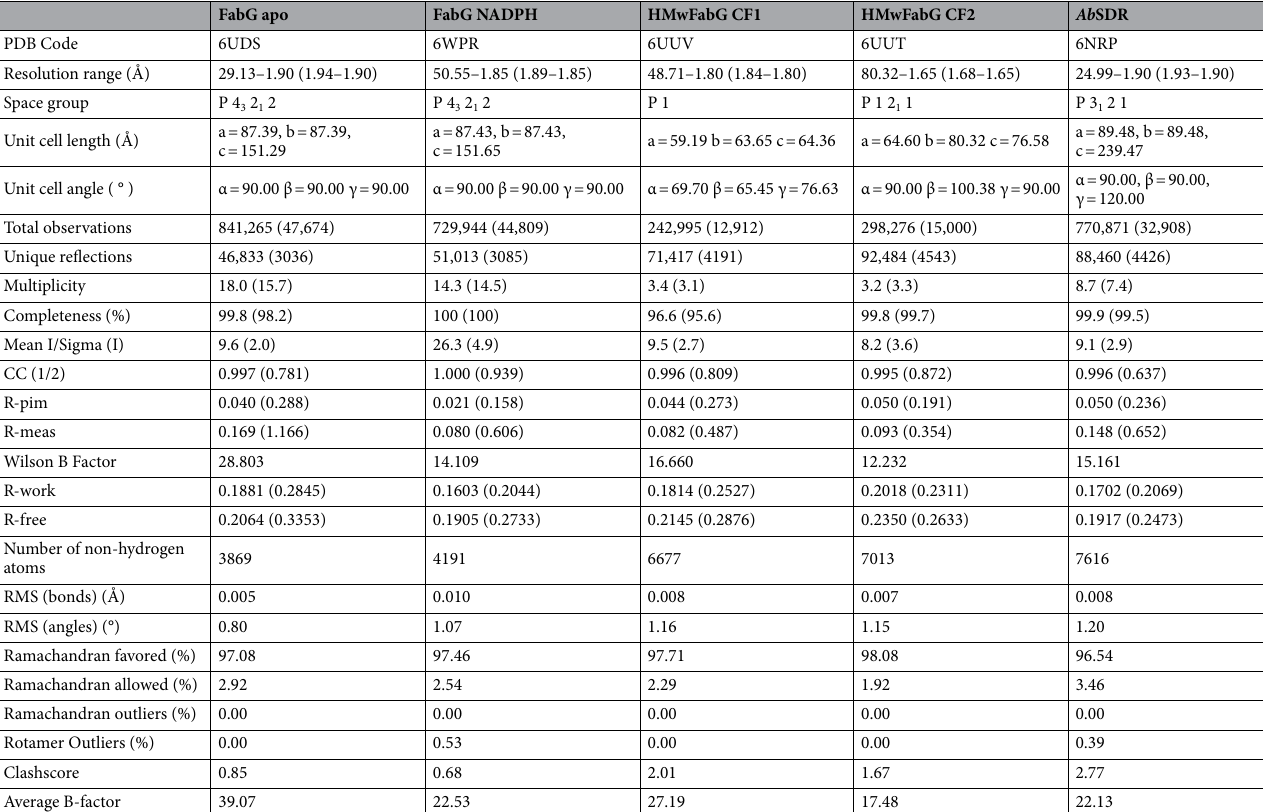
Table 1. Data-collection and model statistics. Overall and (outer